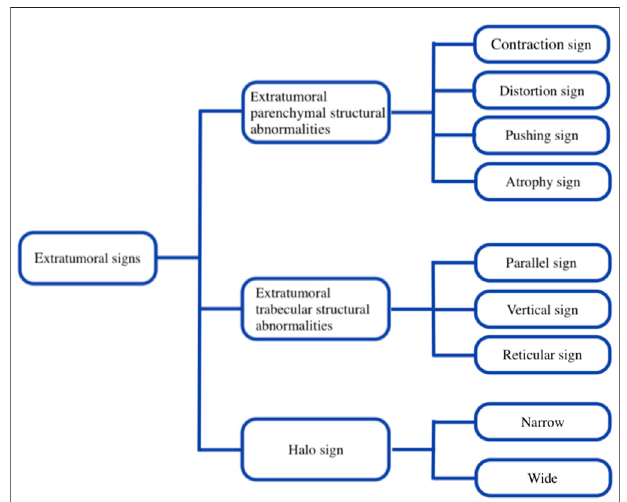
FIGURE 3 | Subclassi fi cation of parenchymal abnormalities. (A) A mass with extratumoral contraction sign of parenchyma in a 49-year-old woman proved to be invasive ductal carcinoma grade Ⅱ pathologically. (B) A mass with extratumoral distortion sign of parenchyma in a 48-year-old woman proved to be invasive ductal carcinoma grade Ⅲ pathologically. (C) A mass with extratumoral pushing sign of parenchyma in a 45-year-old woman proved to be fi broadenoma pathologically. (D) A mass with extratumoral atrophy sign of parenchyma in a 45-year-old woman proved to be invasive ductal carcinoma grade Ⅲ pathologically.